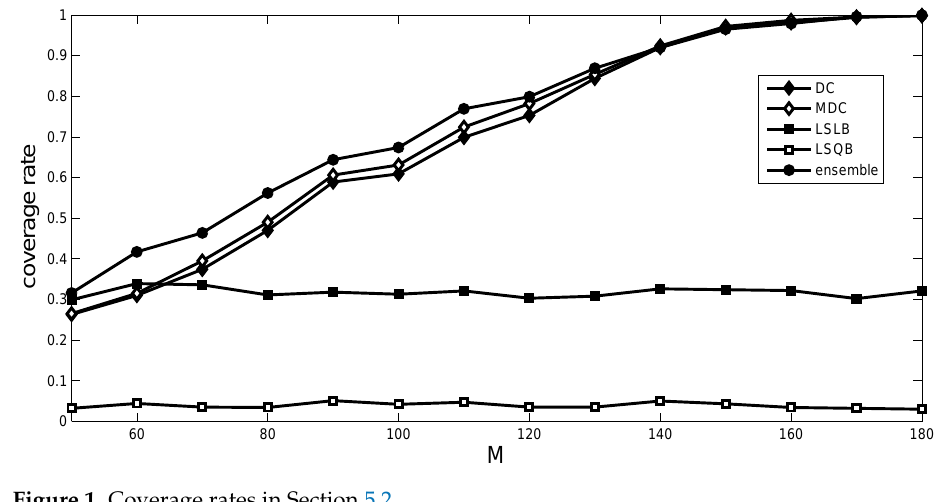
Figure 1. Coverage rates in Section